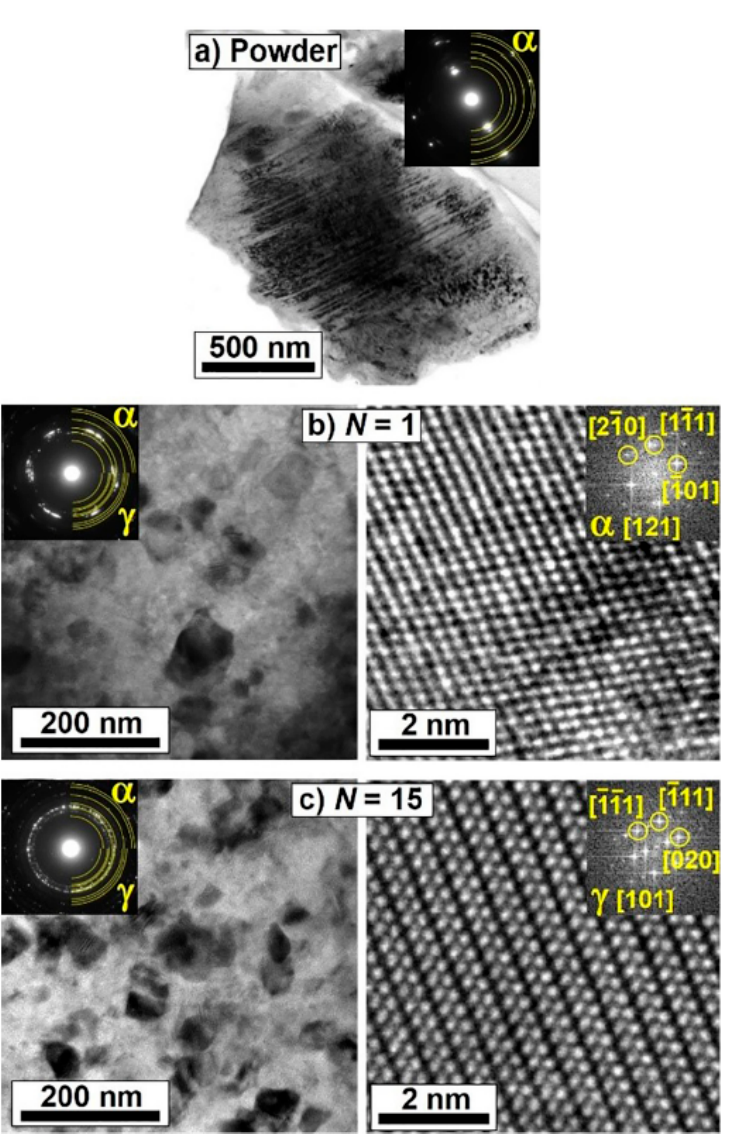
Figure 3. TEM images and corresponding SAED patterns (left) together with high-resolution lat- tice images and corresponding FFT diffractograms (right) for ( a ) tetragonal α -MgH 2 powder, disk processed by HPT under p=6 GPa for ( b ) N = 1 and ( c ) N = 15 whole turns [57].